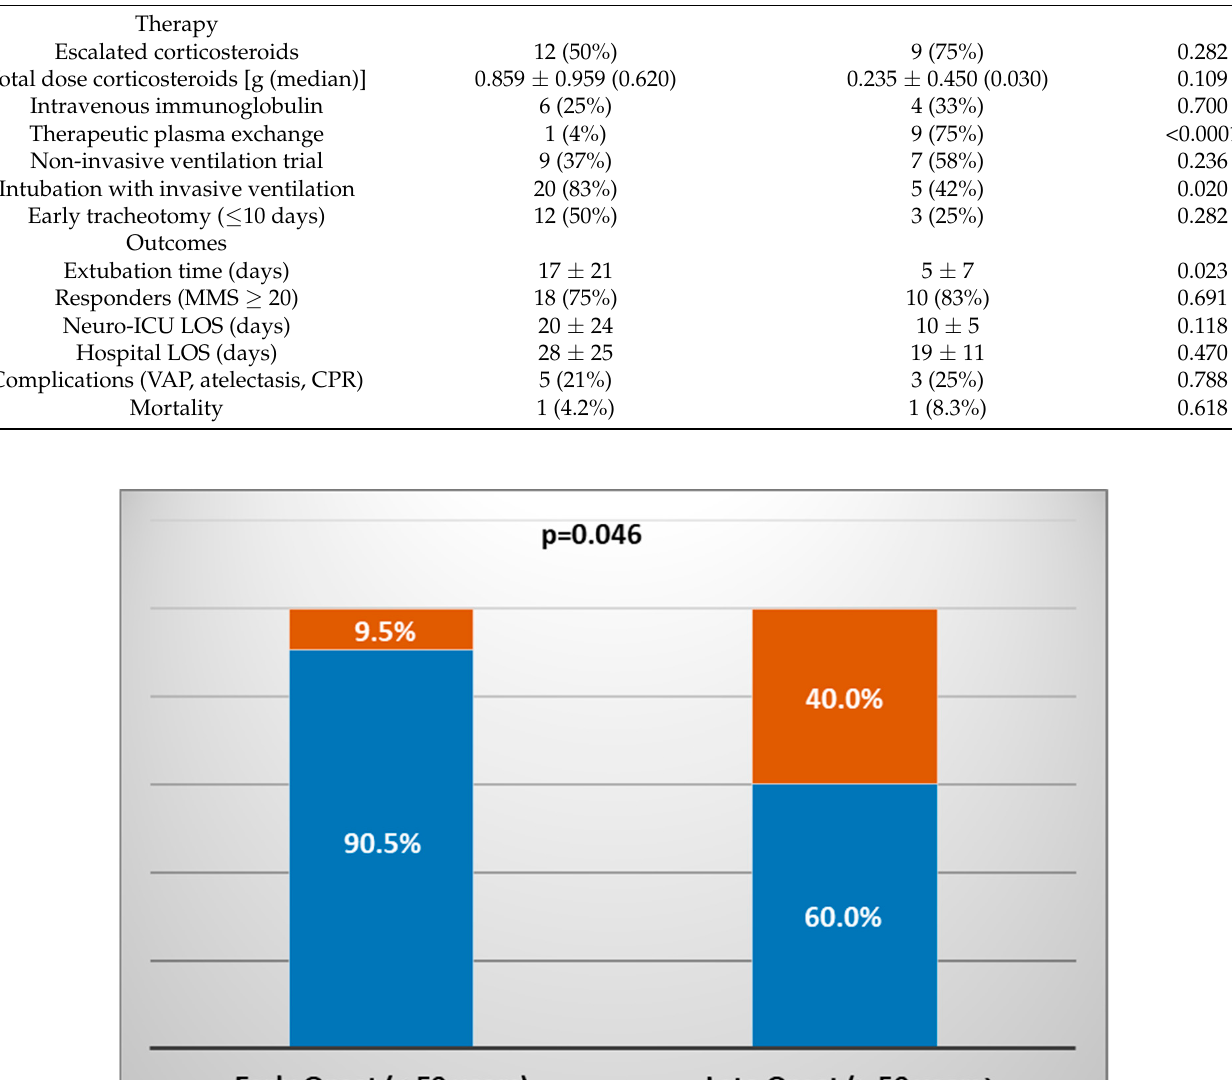
Table 3. Potential factors of clinical relevance to short-term respiratory support during MG acute exacerbations (MGFA—Myasthenia Gravis Foundation of America; ICU—intensive care unit; CCI—Charlson Comorbidity Index).